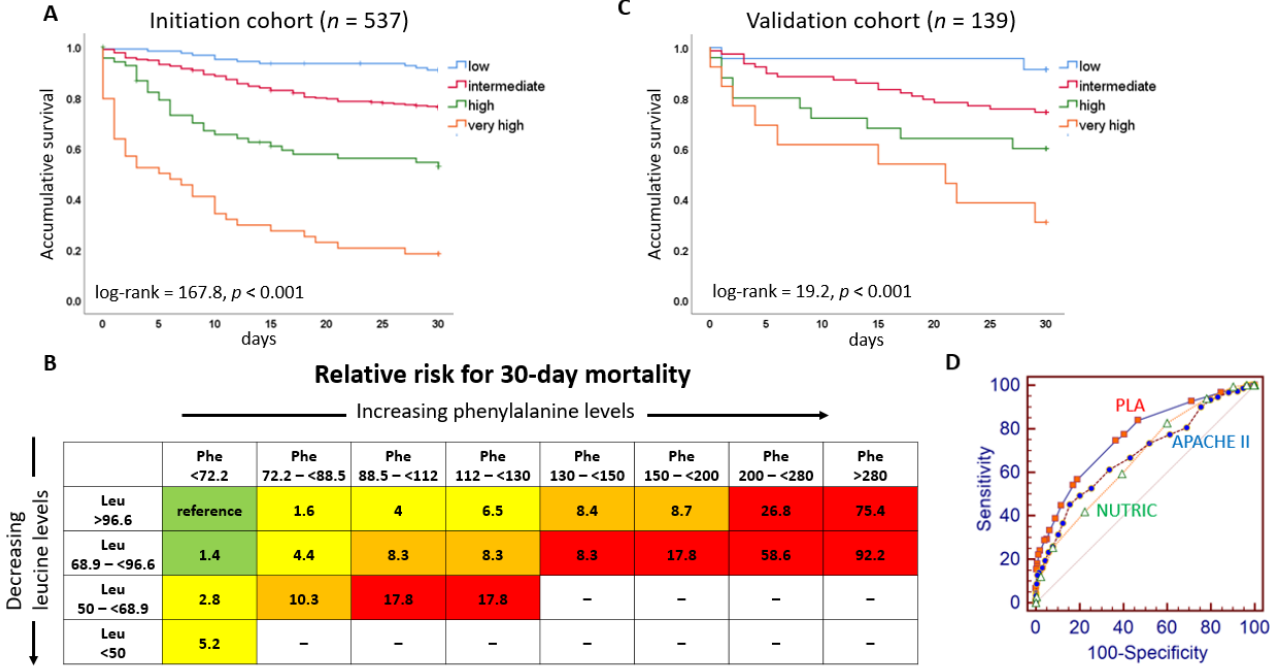
Figure 2. Prognostic value of phenylalanine leucine amino acid (PLA) scores. ( A ) The Kaplan–Meier curves for the four risk levels in the initiation cohort (for all-cause 30-day mortality). ( B ) Phenylalanine and leucine grid reflects the risk of 30-day mortality by intensity of coloring (green: low risk, yellow: intermediate risk, orange: high risk, red: very-high risk). Each cell represents the relative risk compared to the reference cell. “Blank” indicates the condition is not present in our study. ( C ) The Kaplan–Meier curves for the four risk levels in the validation cohort (for all-cause 30-day mortality). ( D ) The ROC curves for PLA, APACHE II, and NUTRIC scores. Abbreviations: Phe, phenylalanine; Leu, leucine; PLA, phenylalanine leucine amino acid score; APACHE II score, Acute Physiology and Chronic Health Evaluation II score; NUTRIC score, Nutrition Risk in the Critically Ill score; ROC curve, receiver operating characteristic curve.